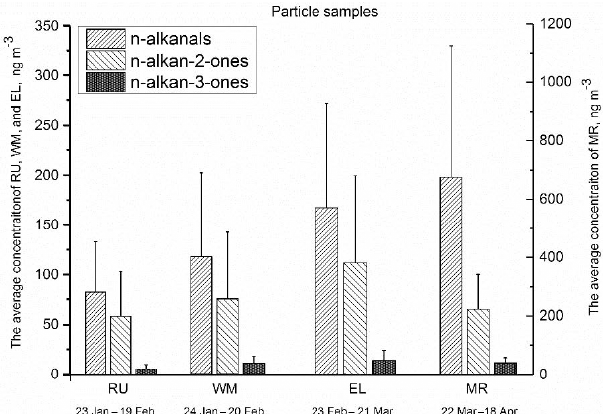
Figure 3. The average total concentration of particle-bound n - alkanals (C 8 –C 20 ), n -alkan-2-ones (C 8 –C 26 ), and n -alkan-3-ones (C 8 –C 19 ) for each sampling period and site. The error bars indicate 1 standard